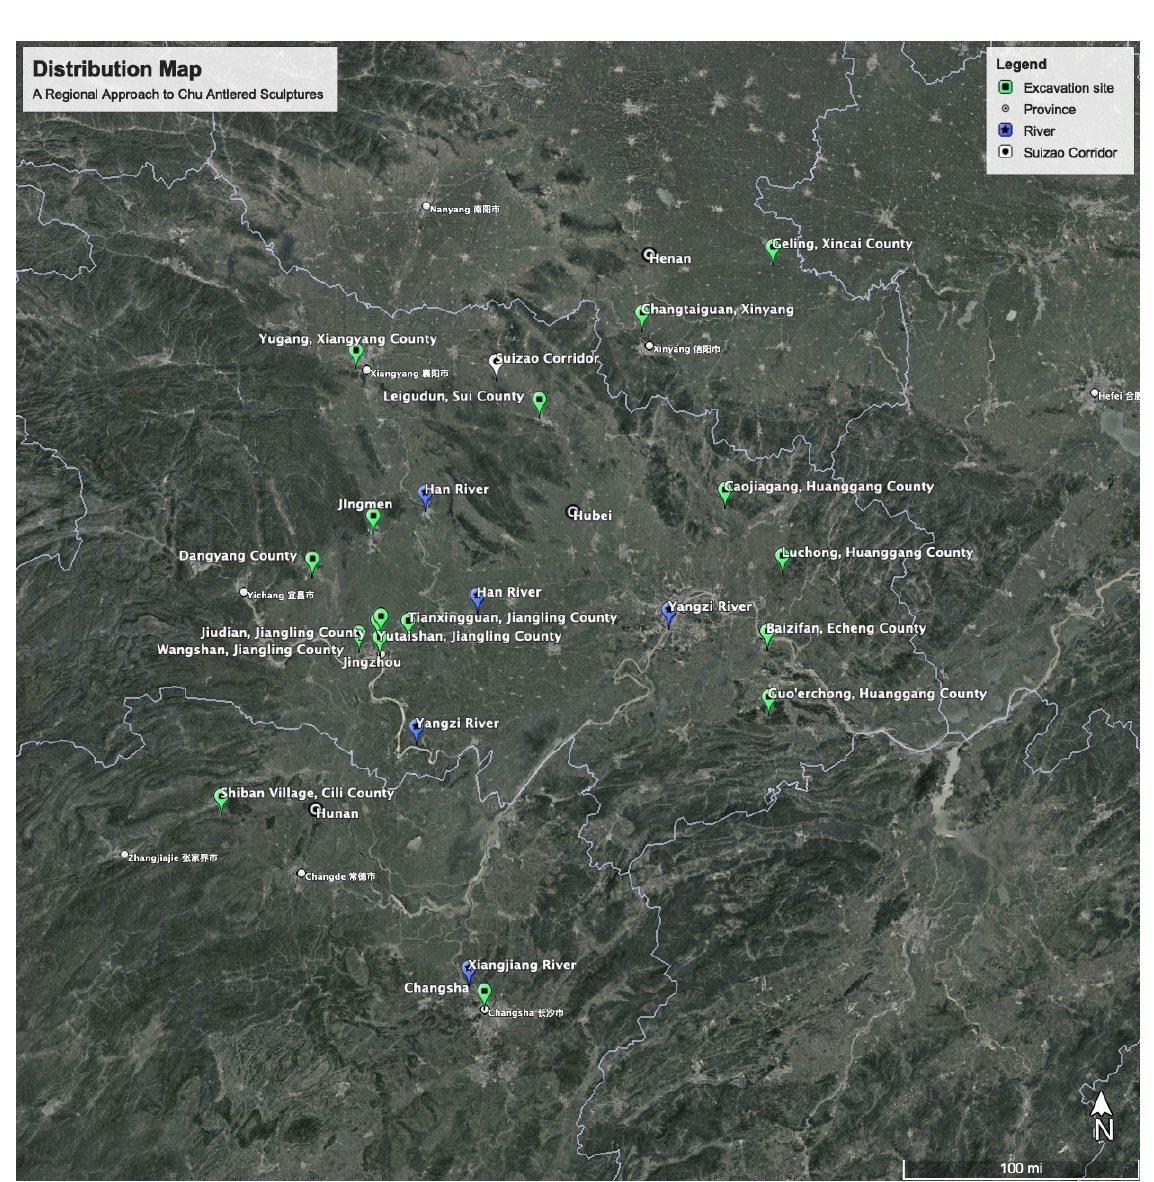
Figure A1. Distribution map showing sites that yielded antlered tomb sculptures discussed in this article. Map by author.